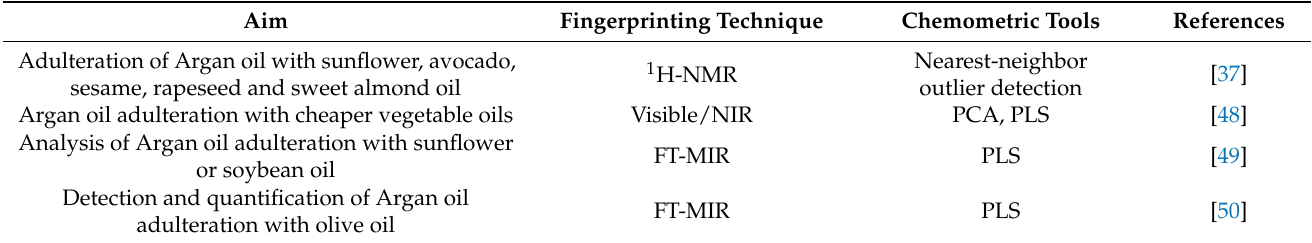
Table 3. Spectroscopic techniques and chemometric tools applied for adulteration evaluation of Argan oil: untargeted